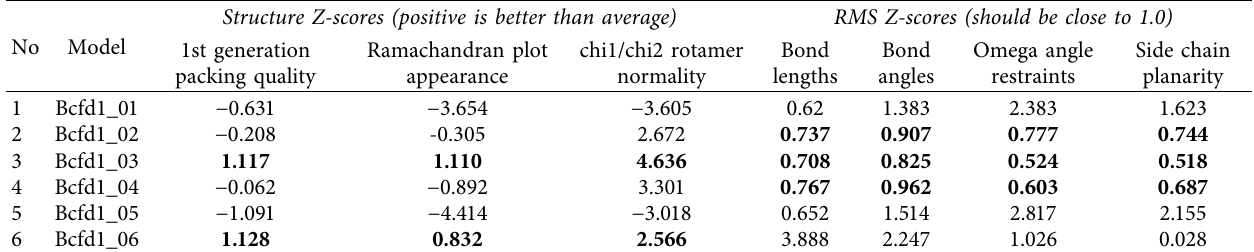
Table 3: Summary of Bcfd1 models evaluation using WHATCHECK.